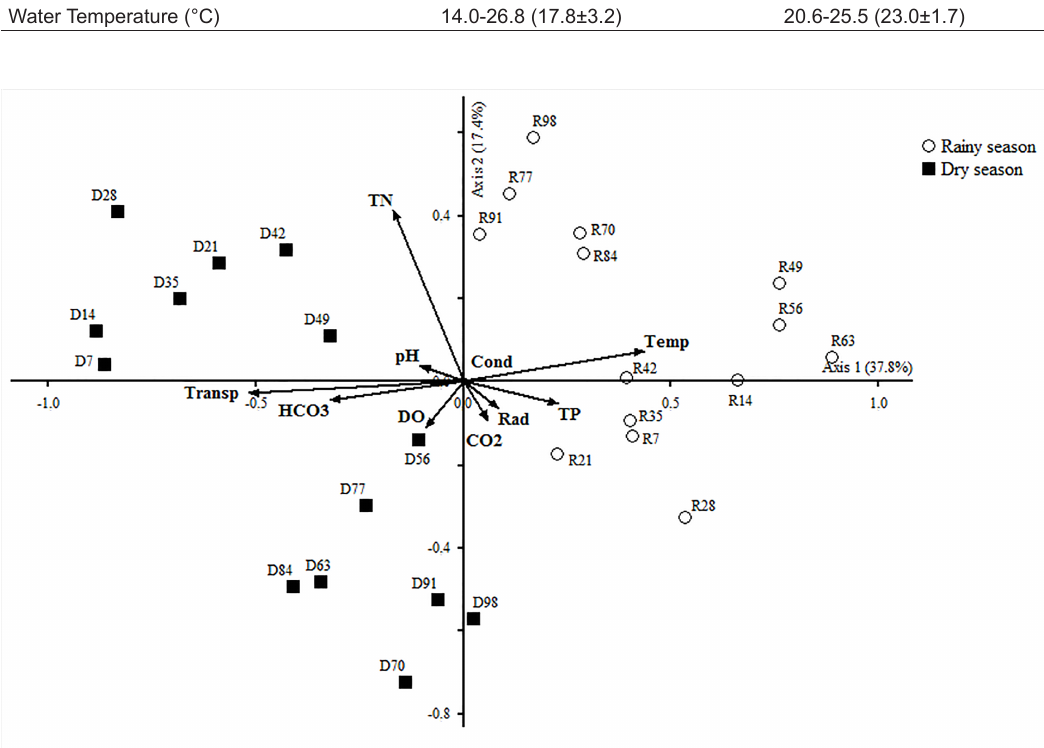
Figure 2. Principal component analysis (PCA) of the limnological variables in Ninfeias reservoir in the rainy and dry seasons. Score abbreviation: first letter refers to climatic season (D: dry season, R: rainy season) and numbers to